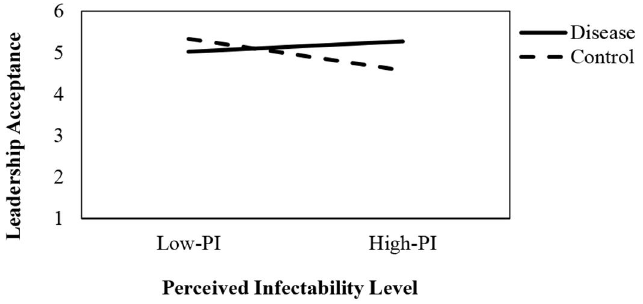
Note. PI = Perceived